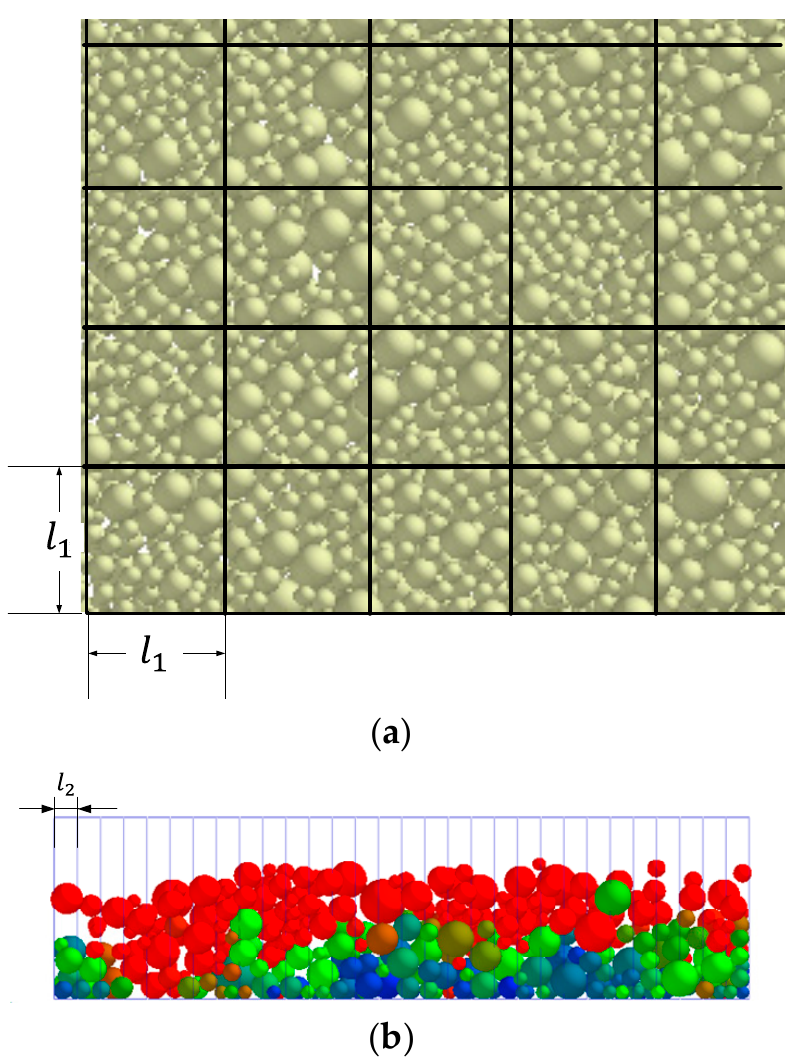
Figure 2. Grid division diagram of apparent density statistics: ( a ) meshing of horizontal plane of powder layer in formation area; ( b ) grid division of vertical plane of powder layer in formation area.